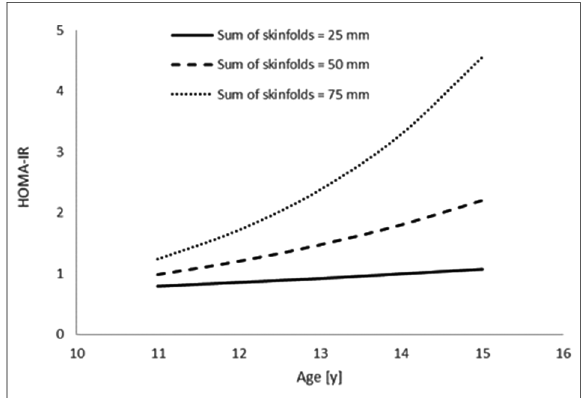
FIGURE 3 The interaction between sum of skinfolds and age, to affect HOMA- IR ( n =45). Modelled data display the mean sum of skinfolds (50 mm)±1 SD (25 mm and 75 mm) (age * sum of skinfolds interaction, p